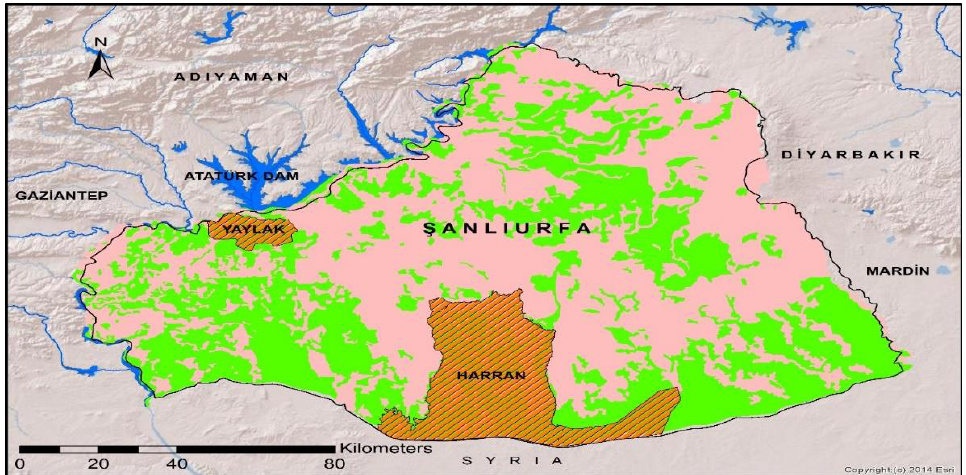
Figure 2. Şanlıurfa -Harran Plain and Yaylak irrigation areas. Figure 2. ¸Sanlıurfa-Harran Plain and Yaylak irrigation